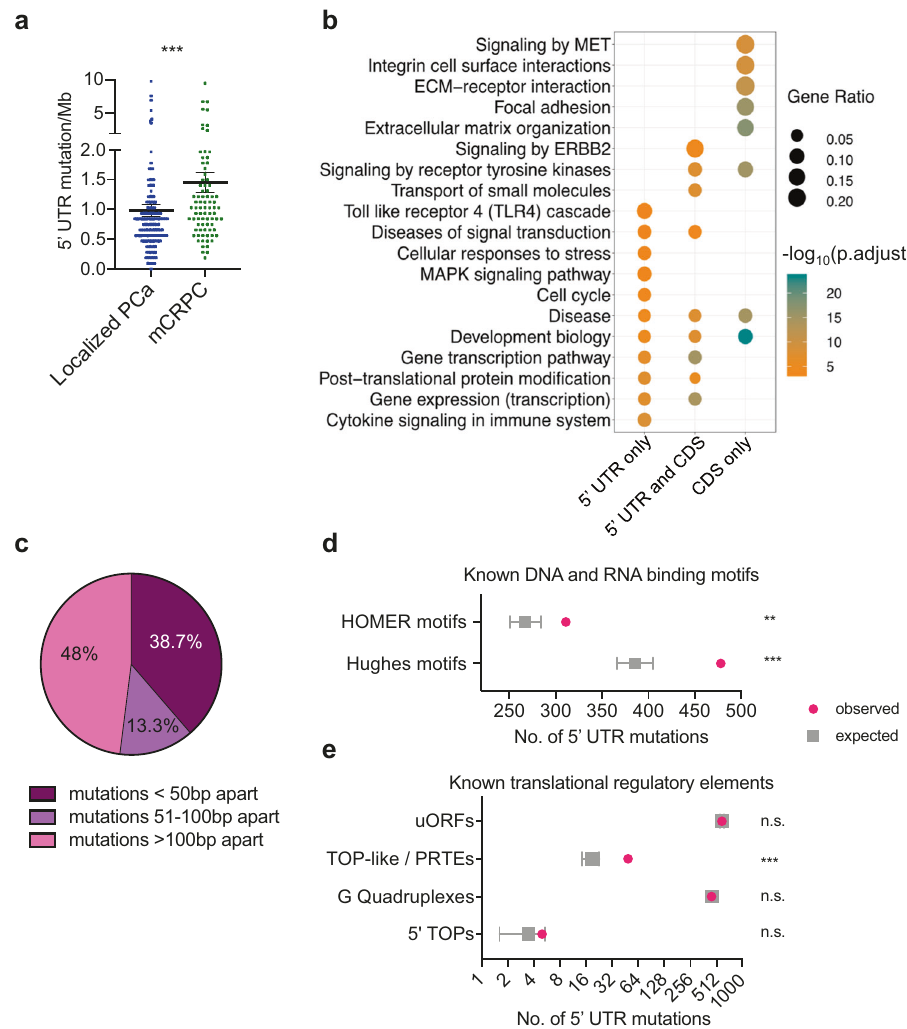
Fig. 2 The mutational landscape of prostate cancer 5 ′ -UTRs. a Comparison of 5 ′ -UTR mutation rate (5 ′ -UTR mutation/Mb) in localized prostate cancer (PCa) patients ( n = 149, each patient represented by a blue dot) and metastatic castration-resistant prostate cancer (mCRPC) patients ( n = 80, each patient represented by a green dot). Each dot represents the mutation rate per patient (*** p = 0.0001, two-tailed Mann – Whitney U test). Data are presented as mean values ± s.e.m. b KEGG and Reactome pathway analyses of all genes with 5 ′ -UTR and protein-coding sequence (CDS) mutations across 229 prostate cancer patients. Genes with 5 ′ -UTR mutations can cluster with or independent of genes with CDS mutations (Fisher ’ s hypergeometric test, FDR < 0.05). c The absolute genomic distance of somatic single-nucleotide 5 ′ -UTR mutations within recurrently mutated genes; 38.7% of recurrently mutated 5 ′ -UTRs have alterations located less than 50-bp apart. d Predicted enrichment of observed 5 ′ -UTR mutations in our patient cohort across known DNA- and RNA-binding regulatory elements. Validated DNA (Homer) and RNA protein-binding motifs (Hughes) were analyzed. To generate the background (null) distribution of mutations, permutations of all 5 ′ -UTR mutation locations ( n = 2200 mutations) found in our dataset were performed ~10,000 times taking into account covariates such as trinucleotide context. The total number of observed mutations (represented by pink dots) impacting each regulatory element type was compared to the background distribution of the permutation data (represented by gray square) and the p value was computed from a distribution obtained from a Monte Carlo simulation (** p = 0.001, *** p = 0.0001). Data are presented as mean values ± s.d. e Predicted enrichment of observed 5 ′ -UTR mutations in our patient cohort across cis -regulatory elements known to affect translation such as upstream open-reading frames (uORFs), terminal oligo pyrimidine (TOP)-like or pyrimidine-rich translational elements (PRTEs), G-quadruplexes, and 5 ′ -TOP elements. To generate the background (null) distribution of mutations, permutations of all 5 ′ -UTR mutation locations ( n = 2200 mutations, represented by pink dots) found in our dataset were performed ~10,000 times taking into account covariates such as trinucleotide context. The total number of observed mutations impacting each regulatory element type was compared to the background distribution of the permutation data (represented by gray square) and the p value was computed from a distribution obtained from a Monte Carlo simulation (*** p = 0.0001). Data are presented as mean values ± s.d. n.s. not statistically signi fi cant. Source data are provided as a Source data fi Functional analysis of 5 ′ -UTR mutations across the spectrum and cancer-associated 5 ′ -UTR mutations identi fi ed in 229 of human prostate cancer . To comprehensively assay the func- patients (Fig. 1e, Supplementary Fig. 7a, and Supplementary tional landscape of 5 ′ -UTR mutations, we developed a second Data 6a). Here, instead of using fi ve 8-bp barcodes per 5 ′ -UTR, a PLUMAGE library. This larger library was composed of 30-bp randomer barcode was cloned downstream of the luciferase 914 synthesized full-length 5 ′ -UTR sequences covering CDS. We constrained the library to 212,325 unique barcodes with 545 somatic mutations from all recurrent (two or more patients) an average of 236 barcodes per 5 ′ -UTR, which enabled deep